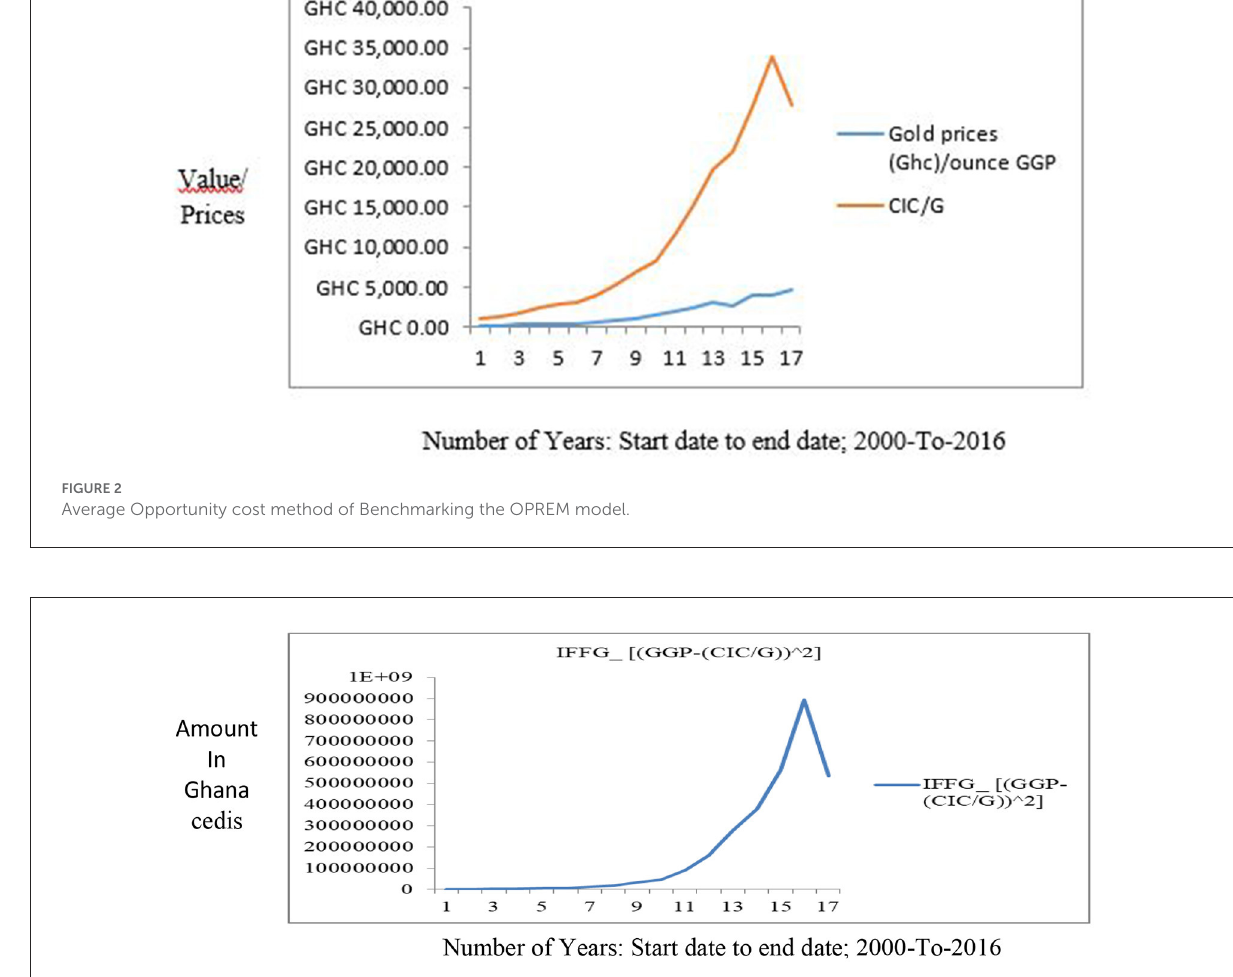
FIGURE3 Ratio Benchmarking of the OPREM